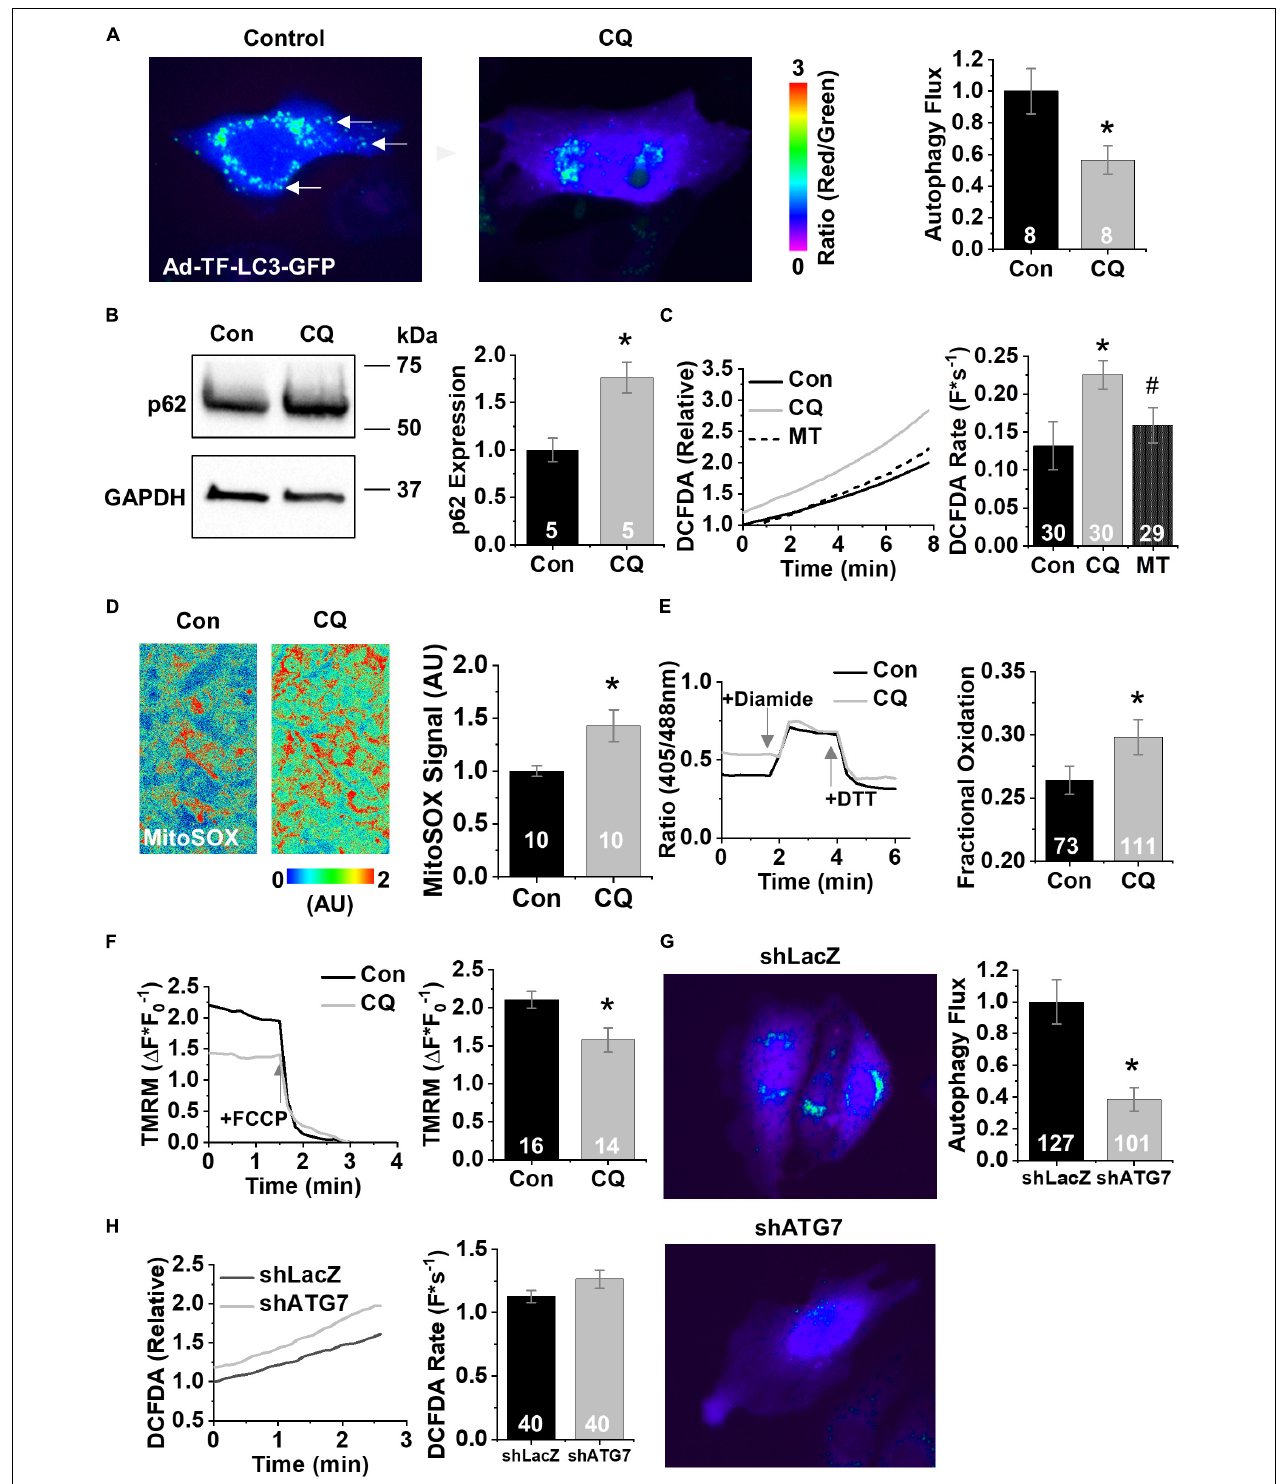
FIGURE 2 | Chloroquine decreases autophagy in HL-1 CMs. (A) Fluorescence images of HL-1 CMs infected with Ad-TF-LC3-GFP visualizing autolysosomes as puncta. Examples of autophagosomes are shown by white arrow. (B) Representative immunoblots for the autophagy protein p62. (C) Changes in DCFDA fluorescence in chloroquine- and vehicle-treated CMs, and from CMs treated with 25 µ M mito-TEMPO for 10 min following chloroquine treatment. Mean data represent ROS production rate. (D) Representative confocal images of HL1 cells stained with MitoSOX acquired in XYT mode. Relative MitoSOX fluorescence